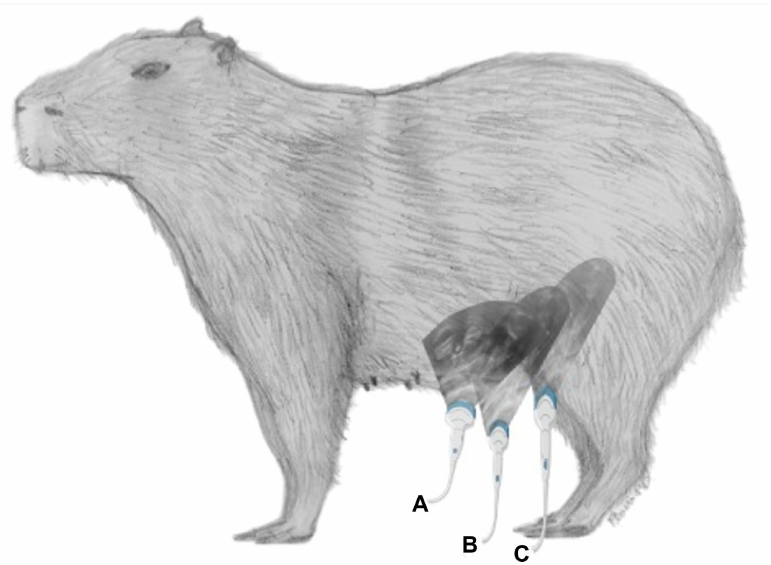
Figure 11. Schematic drawing showing the abdominal regions encompassed by ultrasonography: A. pre-umbilical region; B. umbilical region; C. post-umbilical region. Image created in BioRender.com by Flavia Maria Pia Montenegro Donoso.